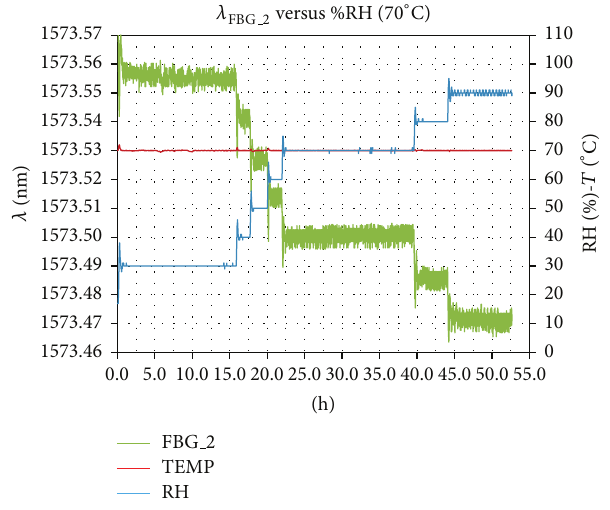
Figure 5: Bragg wavelength shift of FBG 2 (green, left axis) as a function of %RH (blue, right axis) at a temperature of 70 ∘ C (red, right axis).